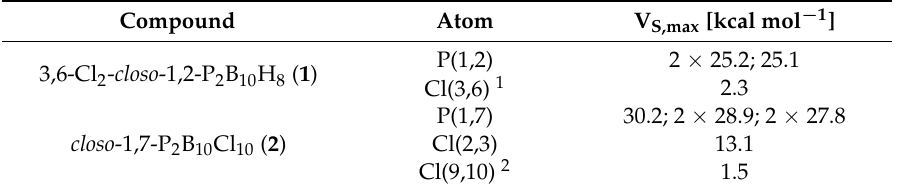
Table 1. The magnitudes of the σ -holes (V S,max ) of the P and Cl atoms.